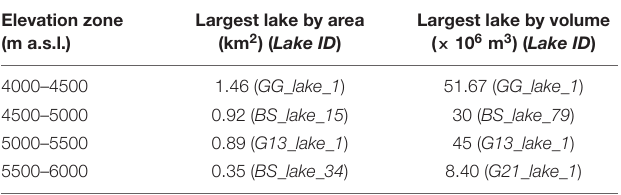
TABLE 5 | Elevation zone-wise largest potential future glacial lake information based on their area and storage volume. Elevation zone (m